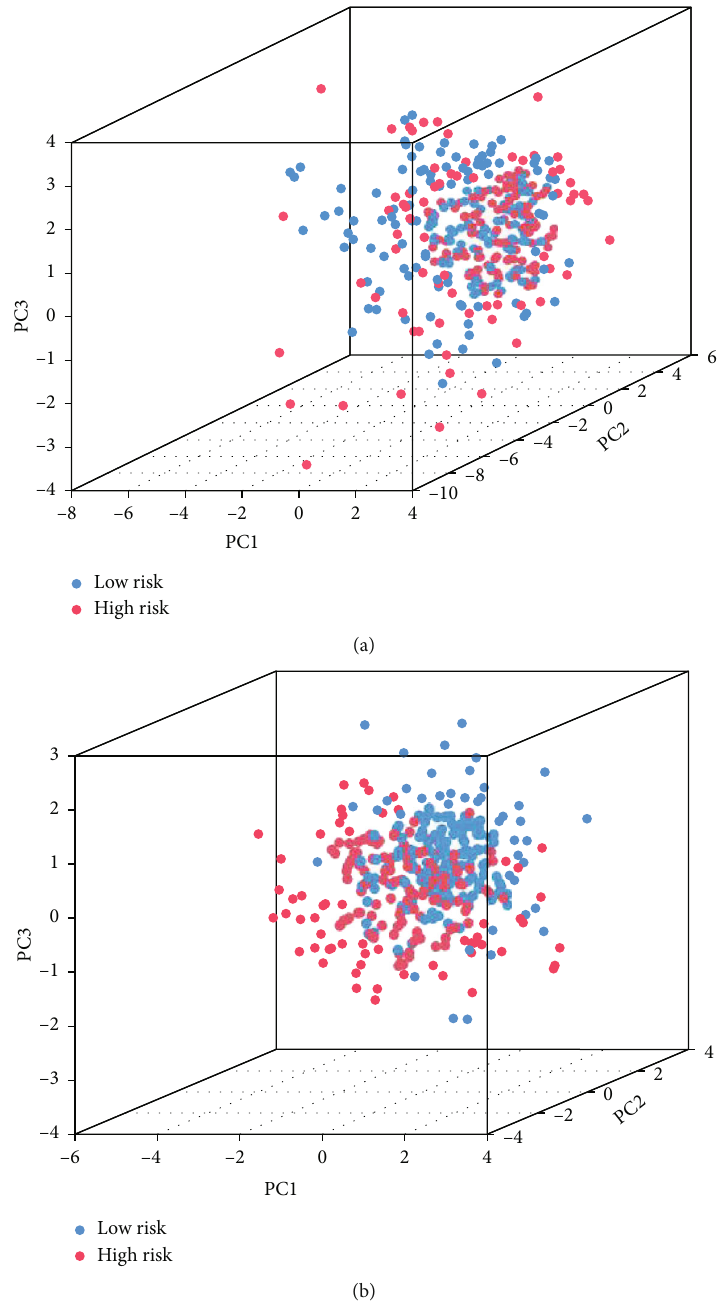
Figure 4: PCA distribution map. (a) PCA map of cuproptosis-related genes. (b) PCA map of GC-related risk